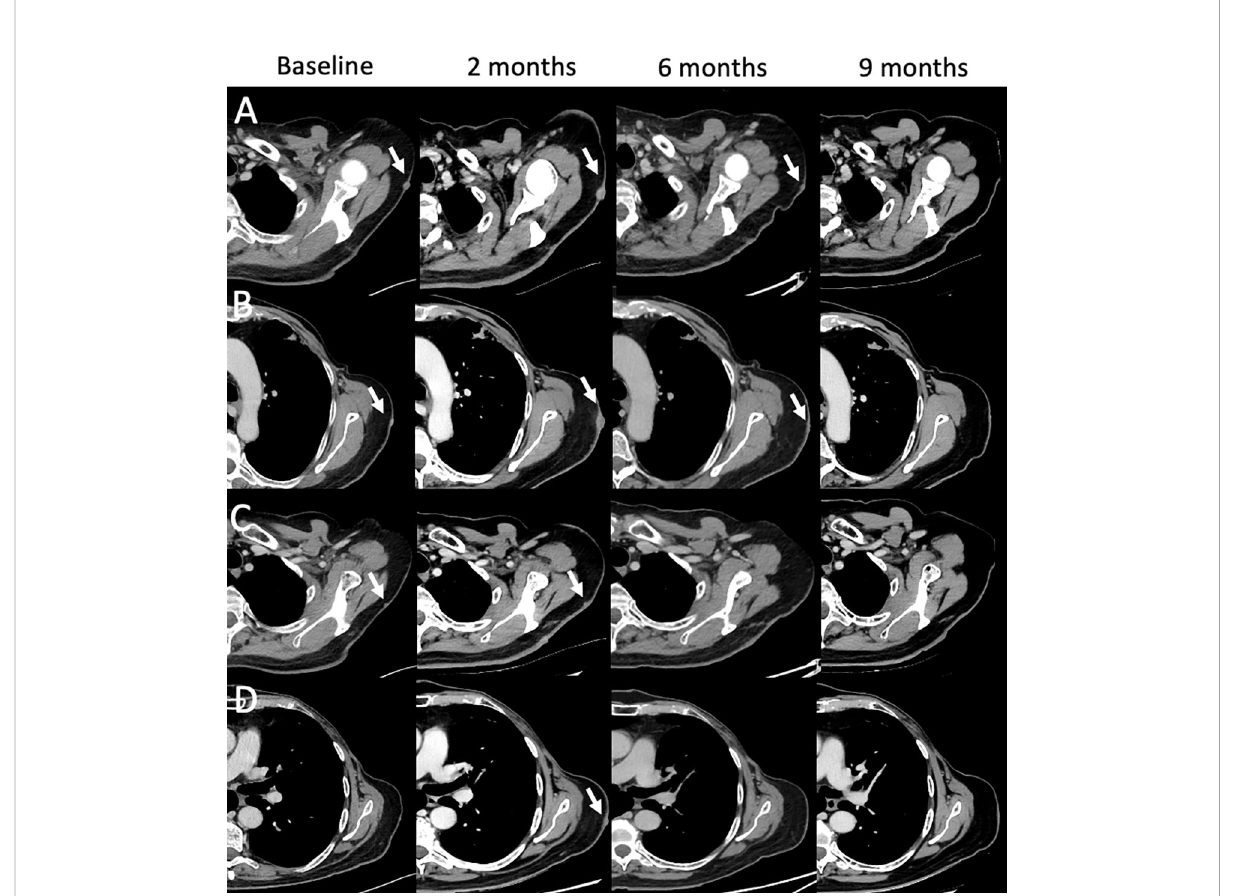
FIGURE 9 Mixed and complete responses following T-VEC therapy in a 66-year-old male with stage IIIB nodular multilesional melanoma in the left arm (baseline contrast-enhanced CT, arrows) previously treated with surgery and systemic immunotherapy with ipilimumab & nivolumab. Treatment with T-VEC was performed in up to 8 subcutaneous lesions per session. Following 3-4 treatment cycles, follow-up CTs were performed (at 2, 6, and 9 month). Representative examples of lesion evolution since baseline (A – D) : Follow-up at 2 months showed mixed responses with progressive lesions [ (A, B) , arrows], stable lesions [ (C) , arrow] and new lesions [ (D) , arrow]. Follow-up at 4 months showed partial responses (A, B) and complete responses (C, D) . Follow-up at 9 months showed complete response in all lesions (A – D) . Treatment with T-VEC was